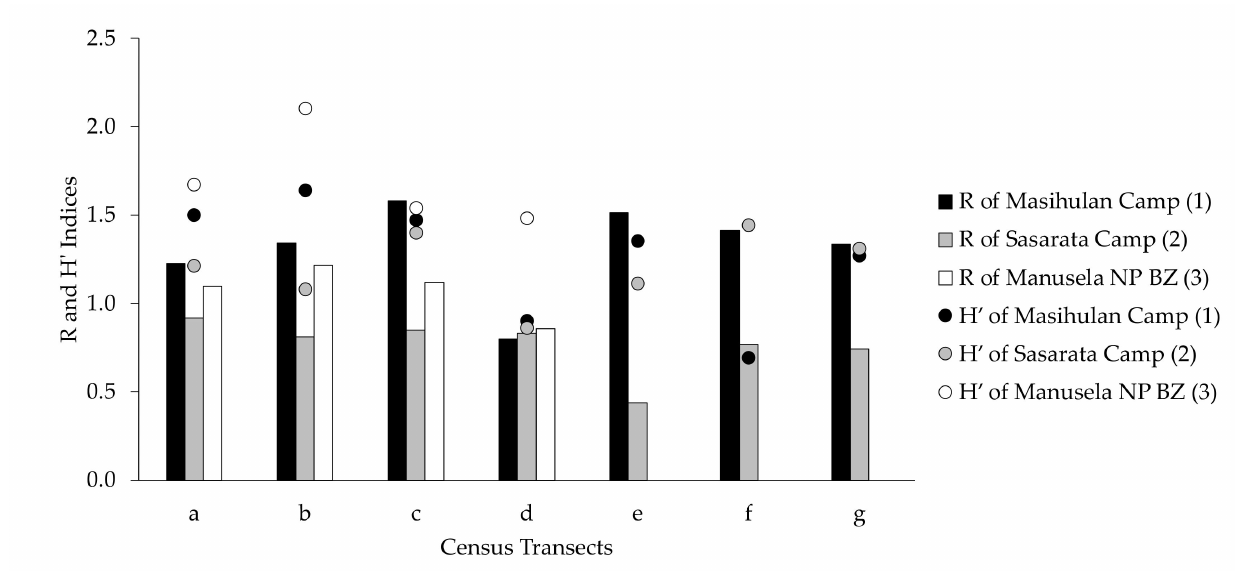
Figure 2. Comparison of species richness ( R ) and species diversity ( H (cid:48) ) across transects. The location of each census transect is shown in Figure